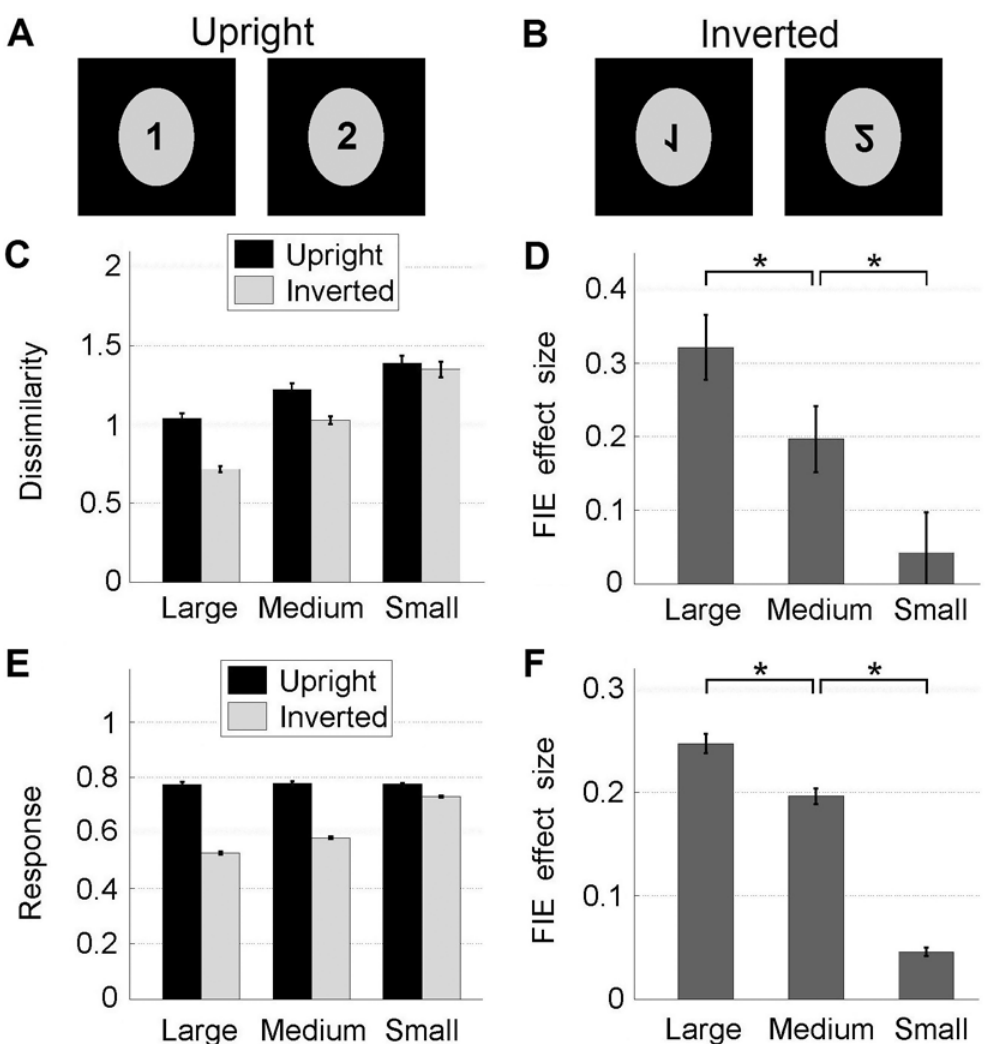
Fig 2. Tuning size accounts for the Face Inversion Effect (FIE) at the behavioral and neural levels. (A-B) Schematic for the FIE: dissimilarity between faces is more apparent for upright (A) than inverted (B) faces. (C) Mean dissimilarities between patterns of C2 responses to two different faces, for all possible pairs of faces. (D) Behavioral FIE effect size (upright dissimilarity – inverted dissimilarity in (C)) varies with tuning size. (E) Results for the neural-level FIE, i.e. mean individual C2 model neuron responses to each face (as opposed to dissimilarities between sets of neural responses to pairs of faces, in (C)) for upright vs. inverted faces. (F) Neural-level FIE effect size (upright response – inverted response in (E)) varies with tuning size. Error bars: SEM.